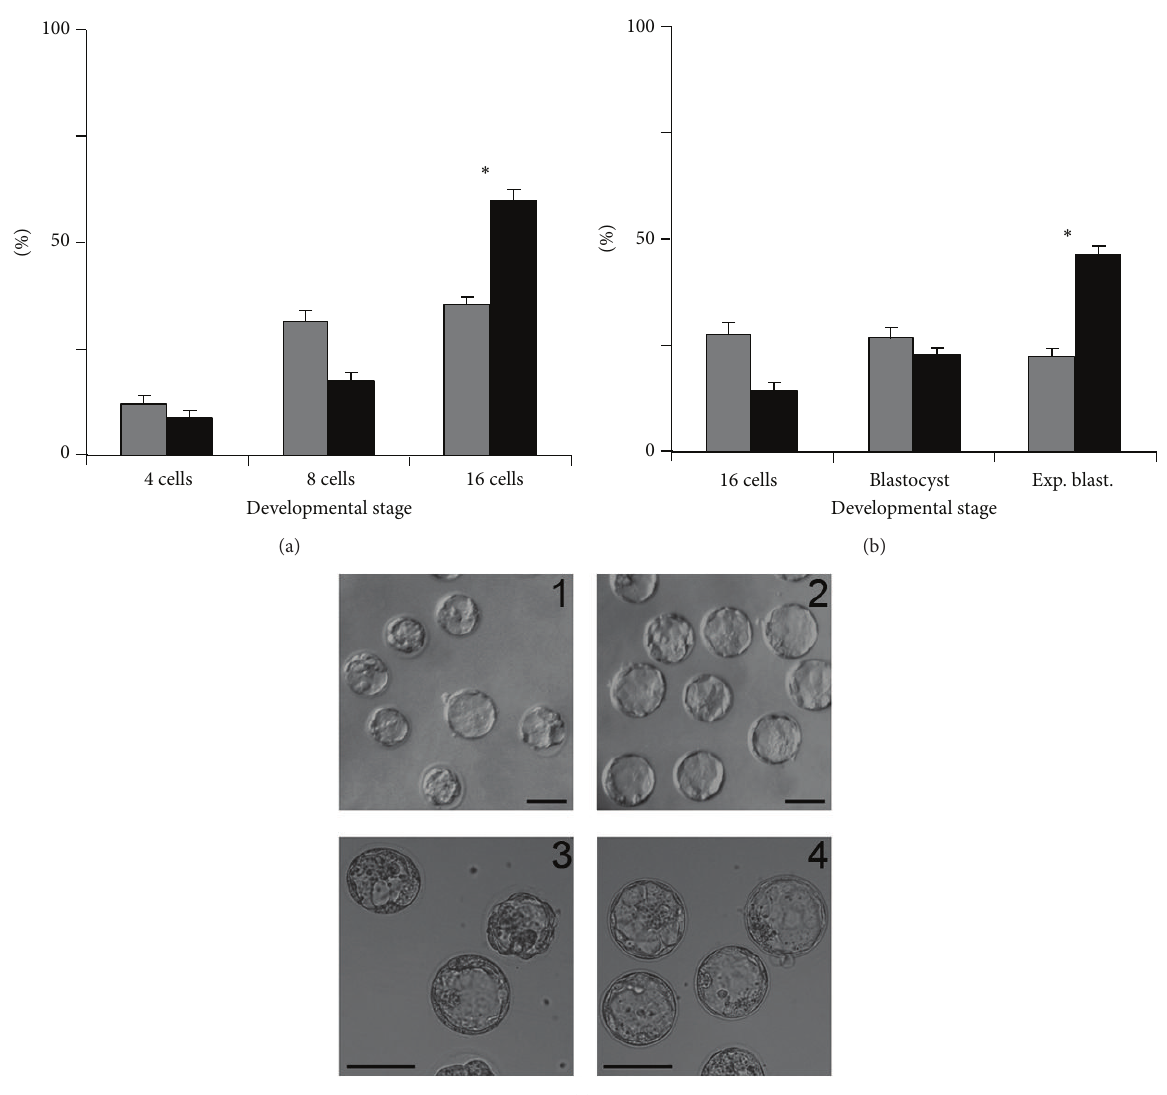
Figure 2: Effect of myo-inositol medium supplementation on embryo development during the third and fourth days of in vitro culture. Completion of mid-to-late preimplantation development by embryos cultured in the absence (grey bars) or the presence (solid bars) of 10mM myo-inositol. Embryos were scored 72–74 hours (a) and 96–98 hours (b) p.f. Bars represent the mean ± SEM of 7 independent experiments of the fraction of embryos at each indicated stage. ((a), (b)) N, myo-Ins − embryos (grey bars), 97; myo-Ins+ embryos (solid bars), 106. Exp. blast.: expanded blastocyst. Asterisks indicate difference between treatments calculated by 𝜒 2 test with Yates correction for continuity: (a) 𝑃 < 0.05 ; (b) 𝑃 < 0.05 . (c) Representative images of expanded and nonexpanded blastocysts observed at day 4 among myo-Ins − (1, 3) and myo-Ins+ (2, 4) embryos; magnification: 40x (1, 2); 80x (3, 4). Black bars, 100 𝜇 m. Panel (b) is modified from